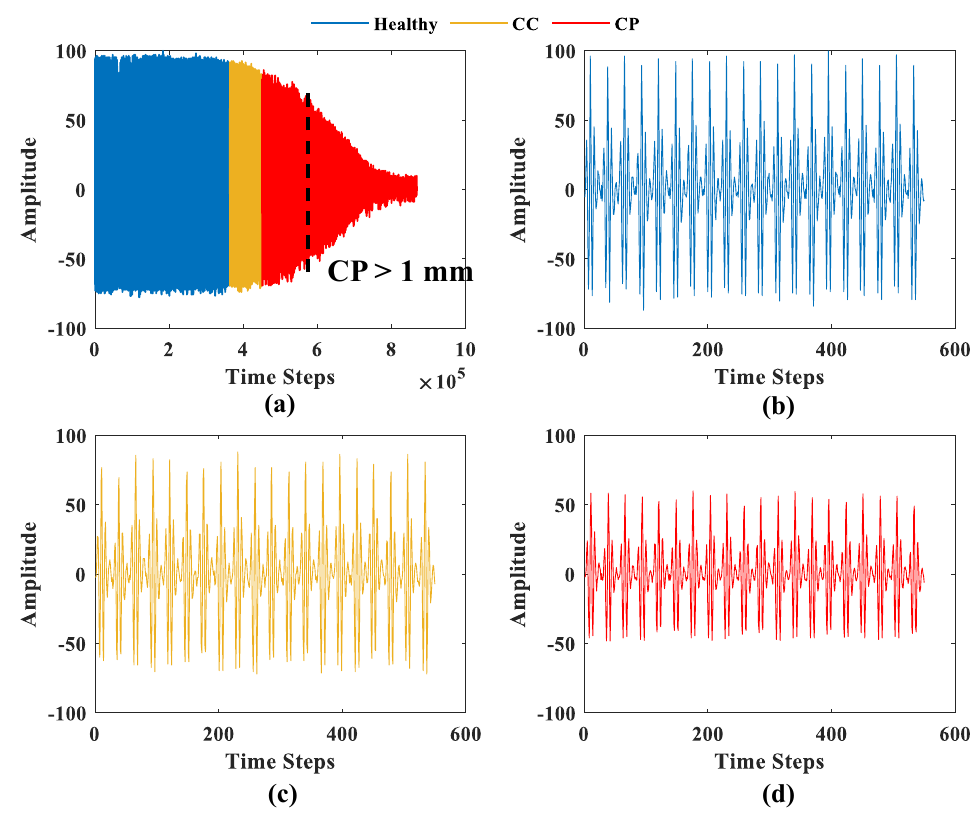
Figure 12. ( a ) Ultrasonic receiver data for a representative U-notched specimen depicting the four regimes, viz. healthy, crack coalescence (CC), crack propagation (CP), and crack length exceeding 1 mm (CP > 1 mm). Zoomed-in views showing the ultrasonic signal in ( b ) healthy, ( c ) CC, and ( d ) CP regimes. The CP > 1 mm regime is marked on ( a ). The V-notched data are similar and are excluded for brevity.